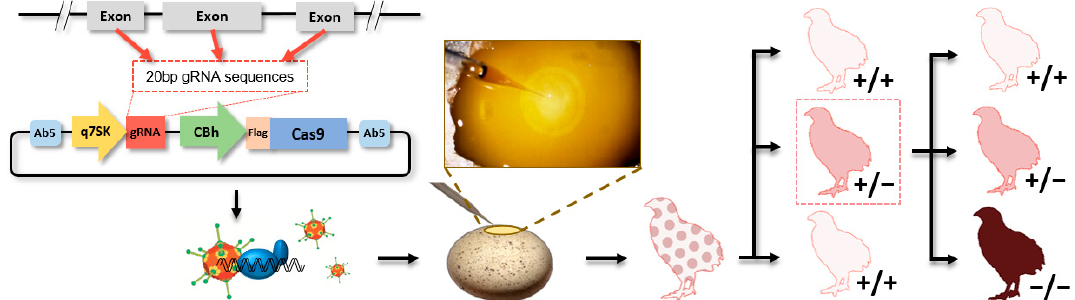
Figure 3. Graphical summary of adenovirus-mediated method for genome editing in quail. After designing guide RNA complement to target sequence in the exon of targeted gene, an adenovirus containing CRISPR / Cas9 system is produced. Then, the adenovirus is injected into the subgerminal cavity of quail blastoderm, and potential germ-line chimeric quail are produced. Subsequently, +/+ and +/ − o ff spring are generated, and +/+ , +/ − , and − / − quail are produced from +/ − parents.